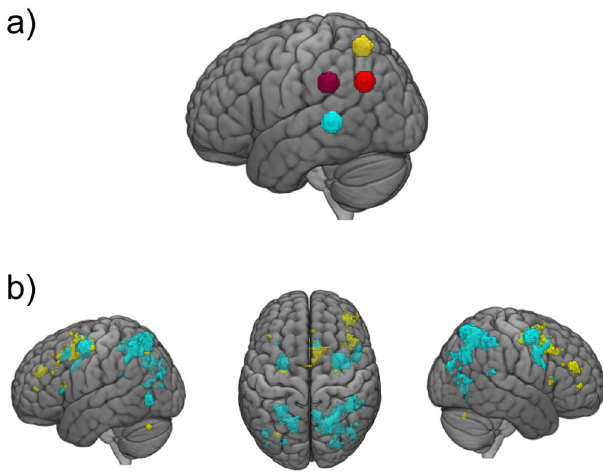
Fig. 5 Regions of interest for literariness and emotional intensity. a Regions of interest based on the Literariness predictor in the left supramarginal gyrus (burgundy), left angular gyrus (red), left superior parietal lobule (precuneus, yellow), and bilaterally a region stretching from the middle to the superior temporal gyrus (cyan, right location not shown, bilateral regions of interest treated as one region for the purpose of this analysis). b Regions of interest based on the Emotional Intensity predictor include the frontal control network (FCN, yellow) and the frontoparietal attention network (FPAN,